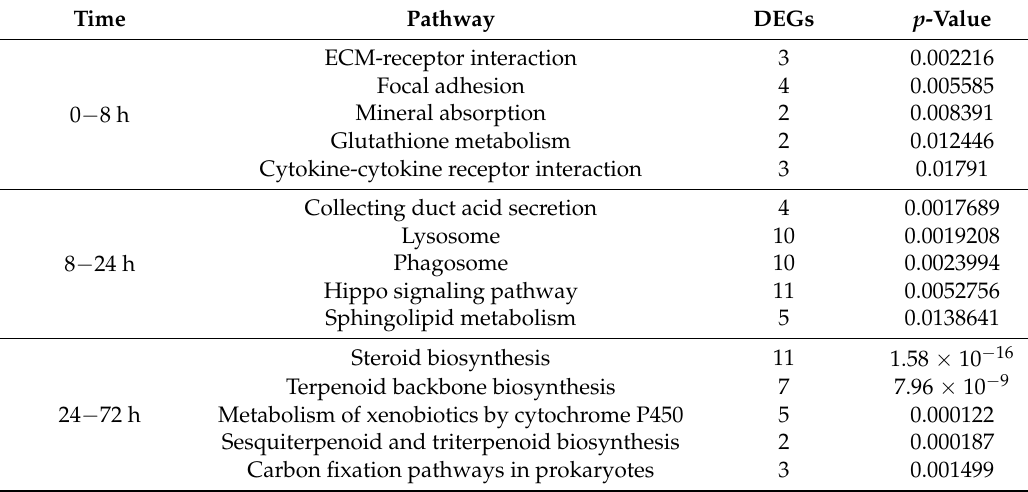
Table 4. KEGG enrichment results of the three stages following